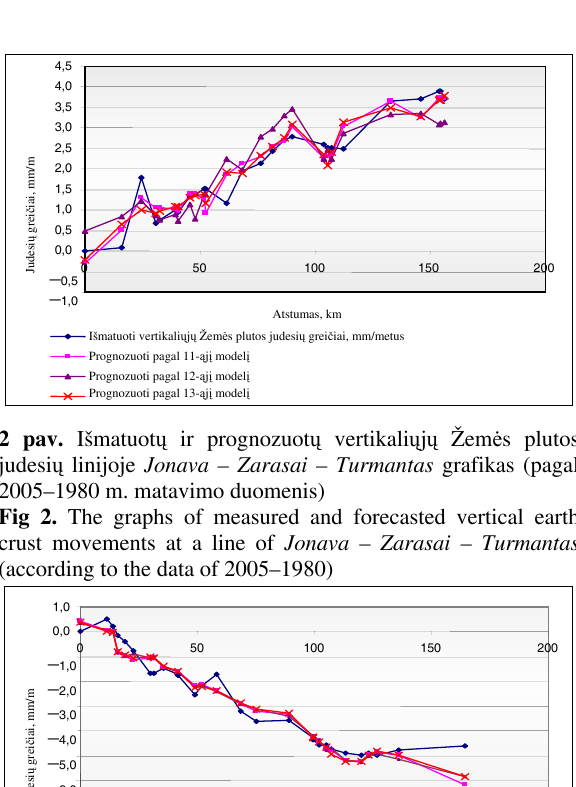
Fig 3. The graphs of measured and forecasted vertical earth crust movements at a line of Turmantas – Vilnius (according to the data of 2005/06–1985/87)